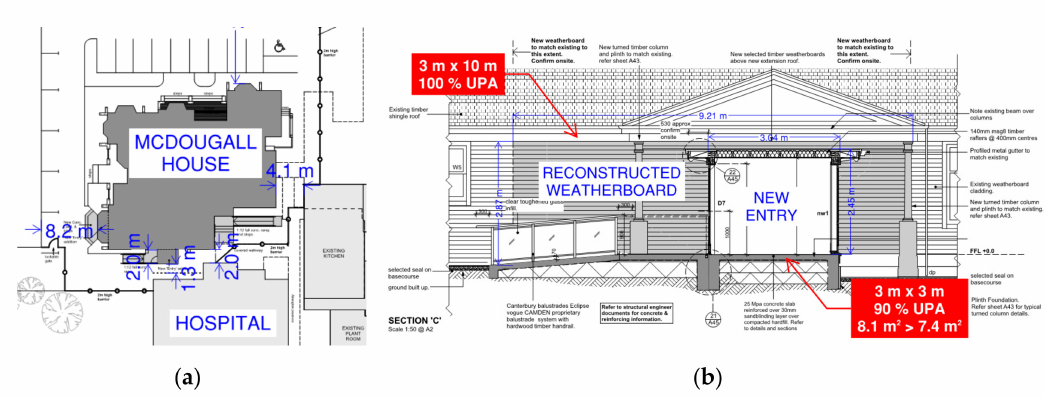
Figure 5. Quantitative assessment of horizontal fire spread across boundary for the new southern entry of McDougall House: ( a ) Distance to the adjacent hospital; ( b ) Proposed work for the new southern entry.